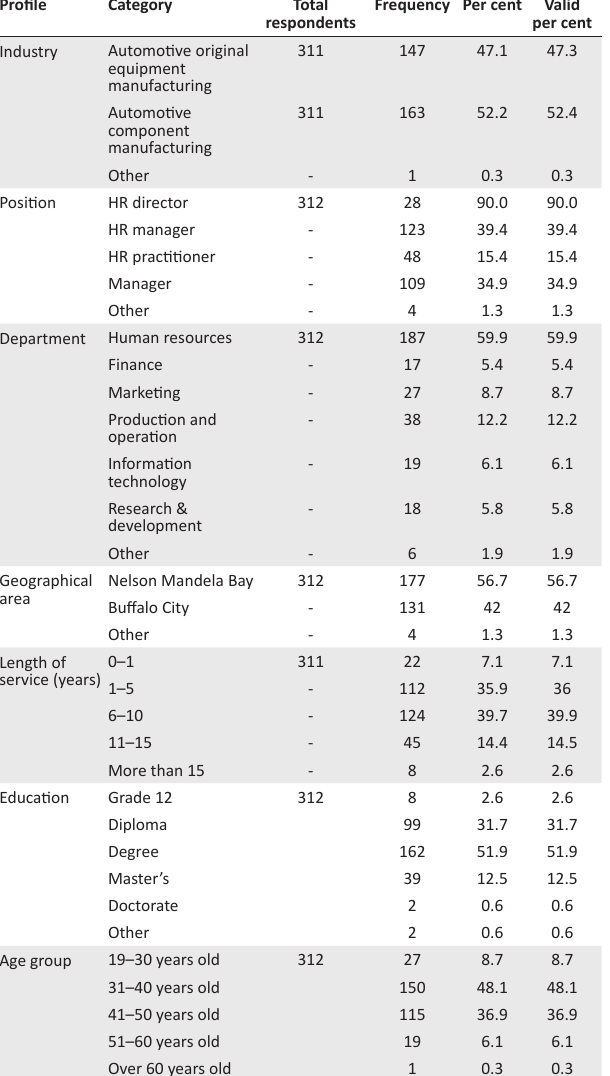
TABLE 1: Demographic profile of